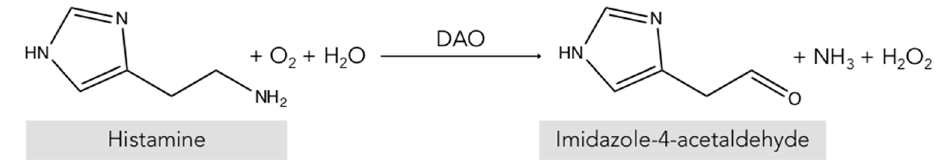
Figure 4. Oxidative deamination of histamine by the DAO enzyme.